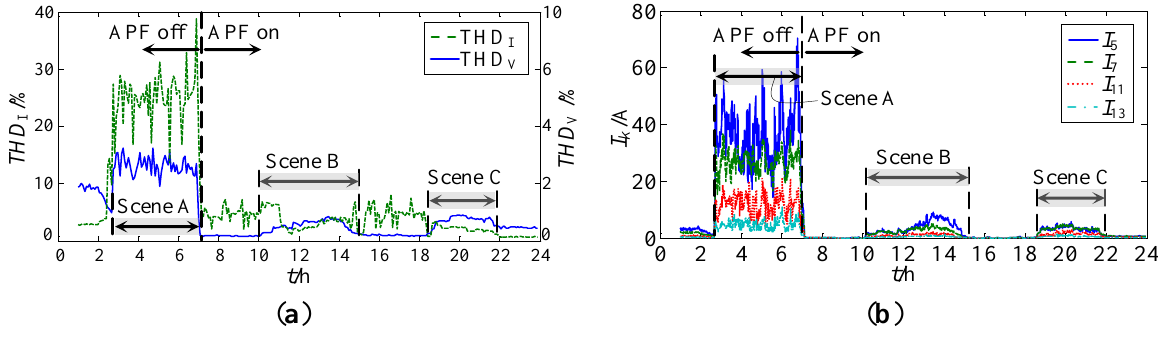
Figure 13. Field test results with the APF disconnected and connected: ( a ) total harmonic distortion and ( b ) individual harmonic